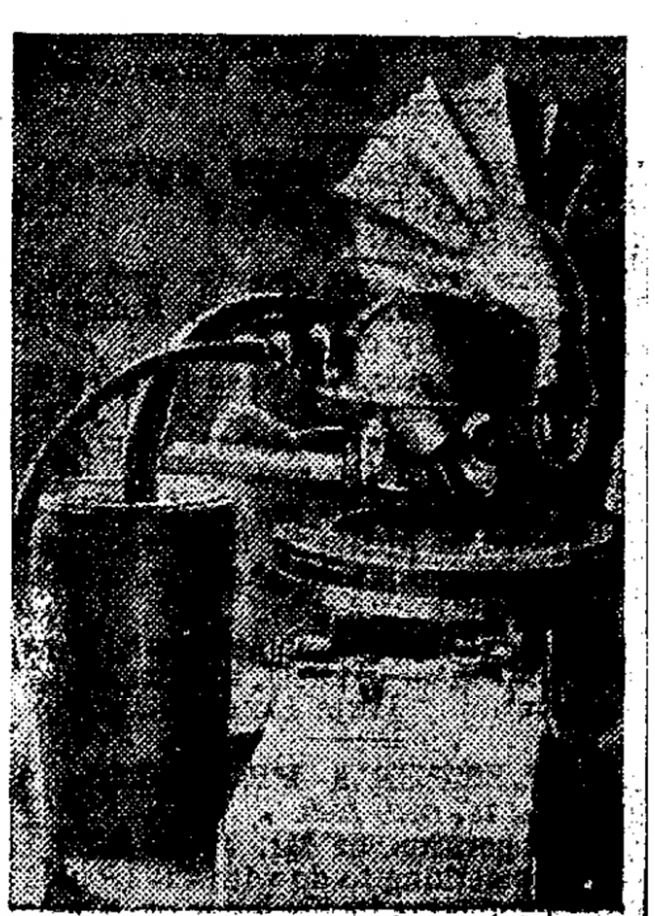
Acoustics 2020 , 3 FOR PEER REVIEW